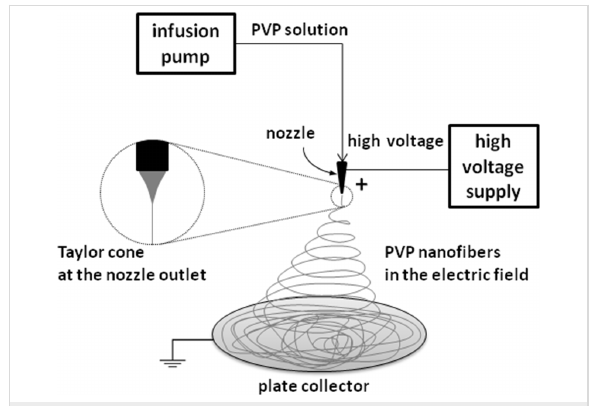
Figure 1: Scheme of the apparatus for the electrospinning process.